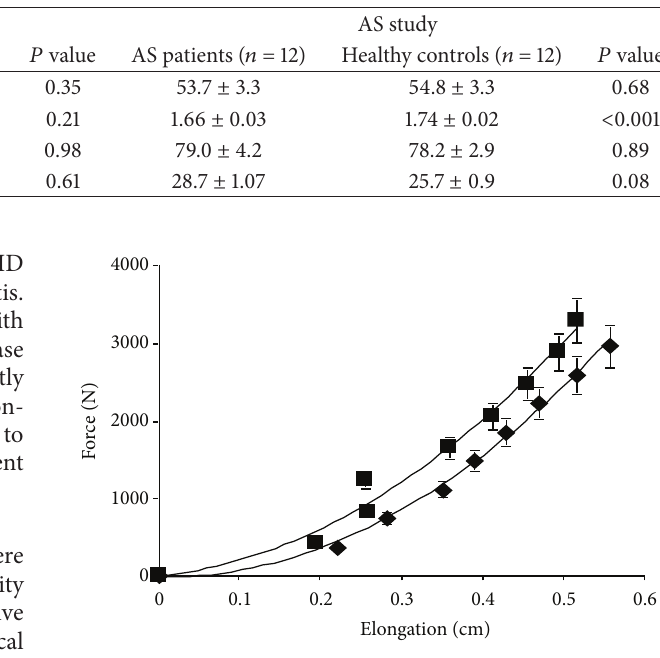
Table 1: Participant anthropometric characteristics. Presented are the data (mean ± SEM) of RA patients ( 𝑛 = 18 ; 13 women) and their age- and sex-matched healthy controls ( 𝑛 = 18 ) as well as the data of AS patients ( 𝑛 = 12 ; 4 women) and their age- and sex-matched controls ( 𝑛 = 12 ).